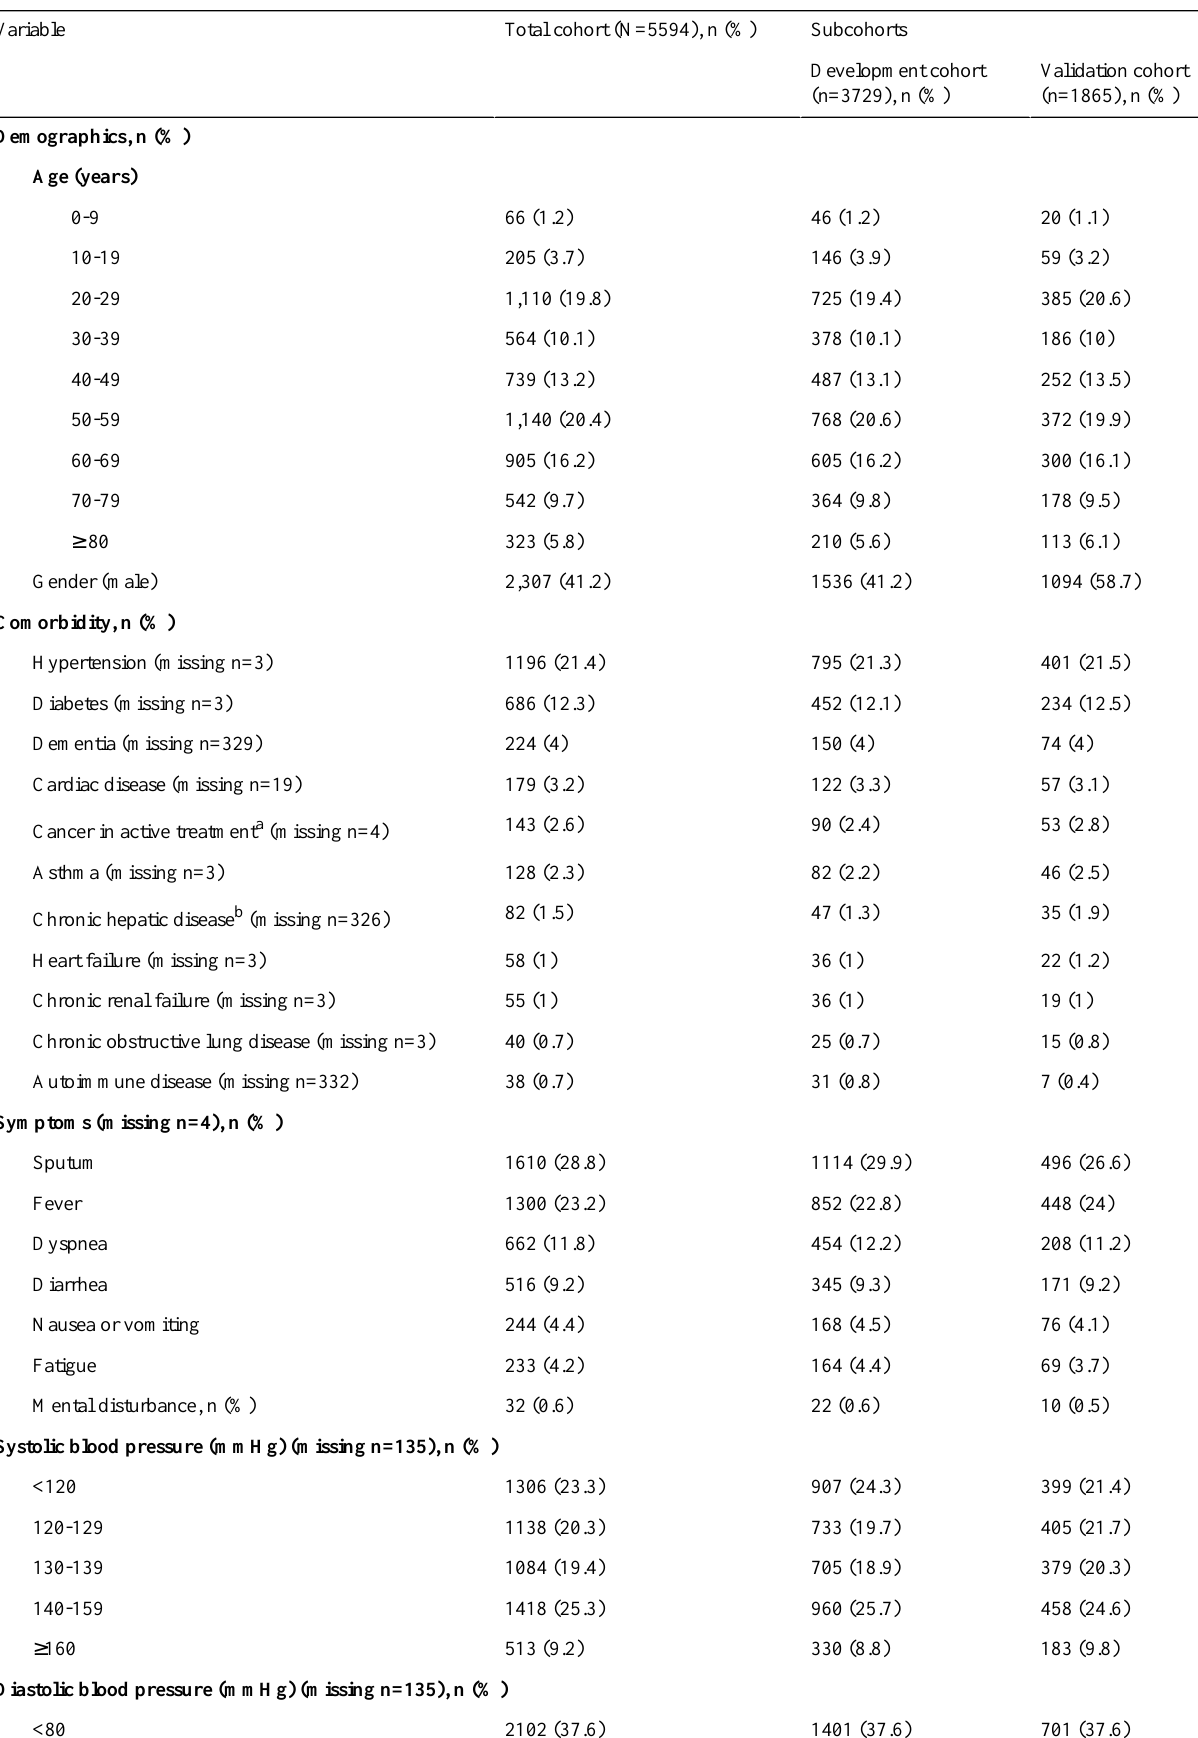
Table 1. Demographics of the study cohorts. All values presented in the table represent data collected at the time of COVID-19